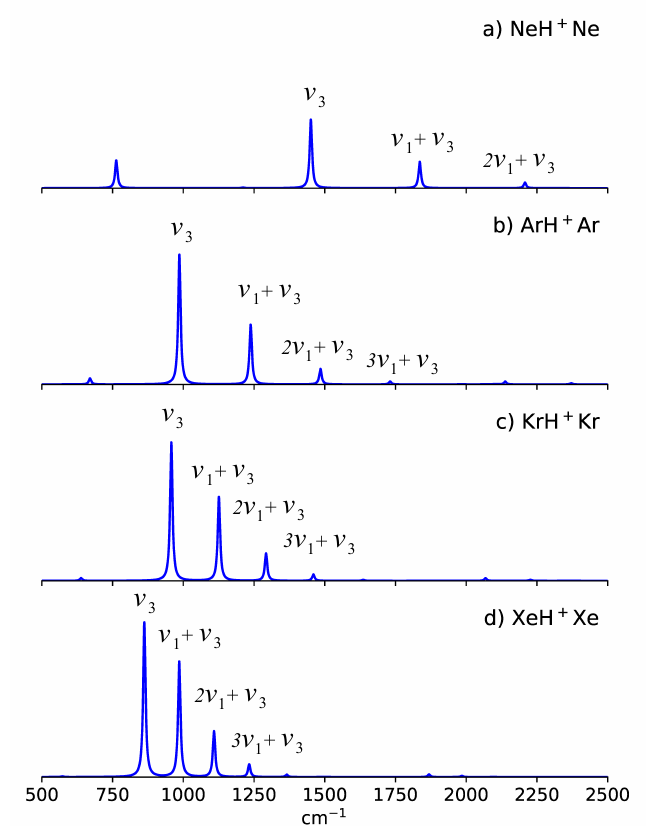
Figure 2. Anharmonic spectrum for ( a ) NeH + Ne, ( b ) ArH + Ar, ( c ) KrH + Kr, ( d ) XeH + Xe. Subplot ( b ) was adapted with permission from Ref. [59]. Copyright 2020 American Chemical Society. Subplots ( c , d ) were adapted with permission from Ref. [60]. Copyright 2021 AIP